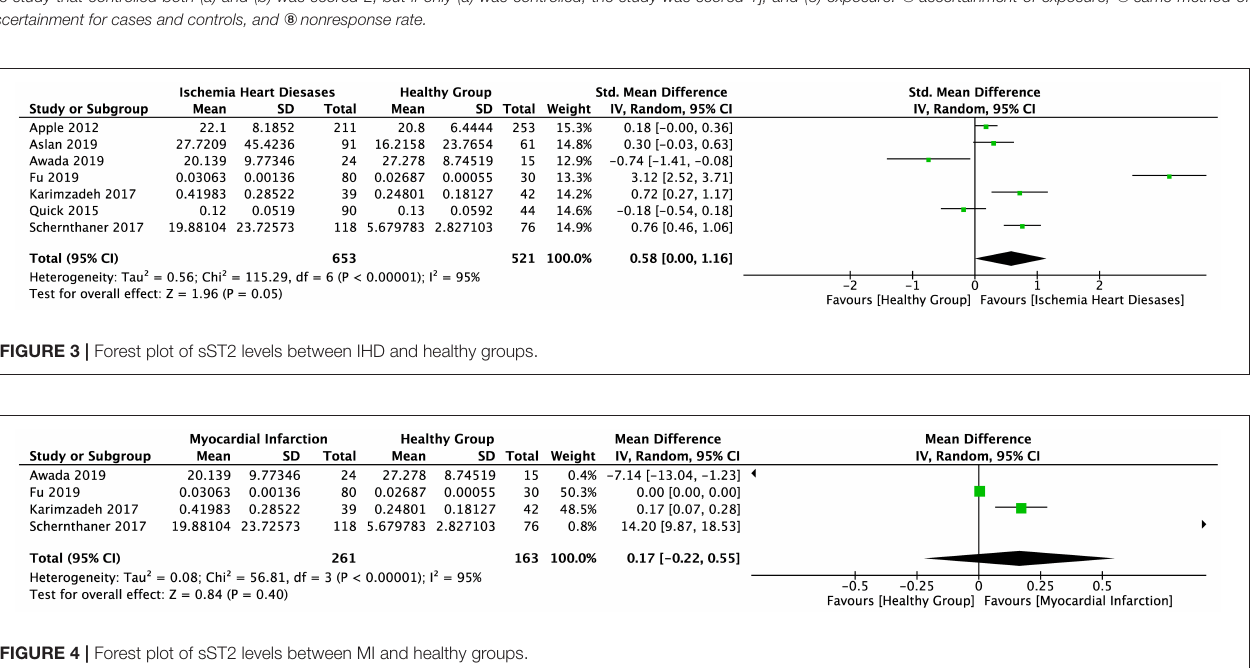
membrane-bound ST2 and subsequent signal transduction (22). sST2 is mainly produced by myocardial fibroblasts and stressed or injured cardiomyocytes and is also expressed in mast cells, epithelial cells, smooth muscle cells, and endothelial cells from the cardiac and microvascular systems (39,